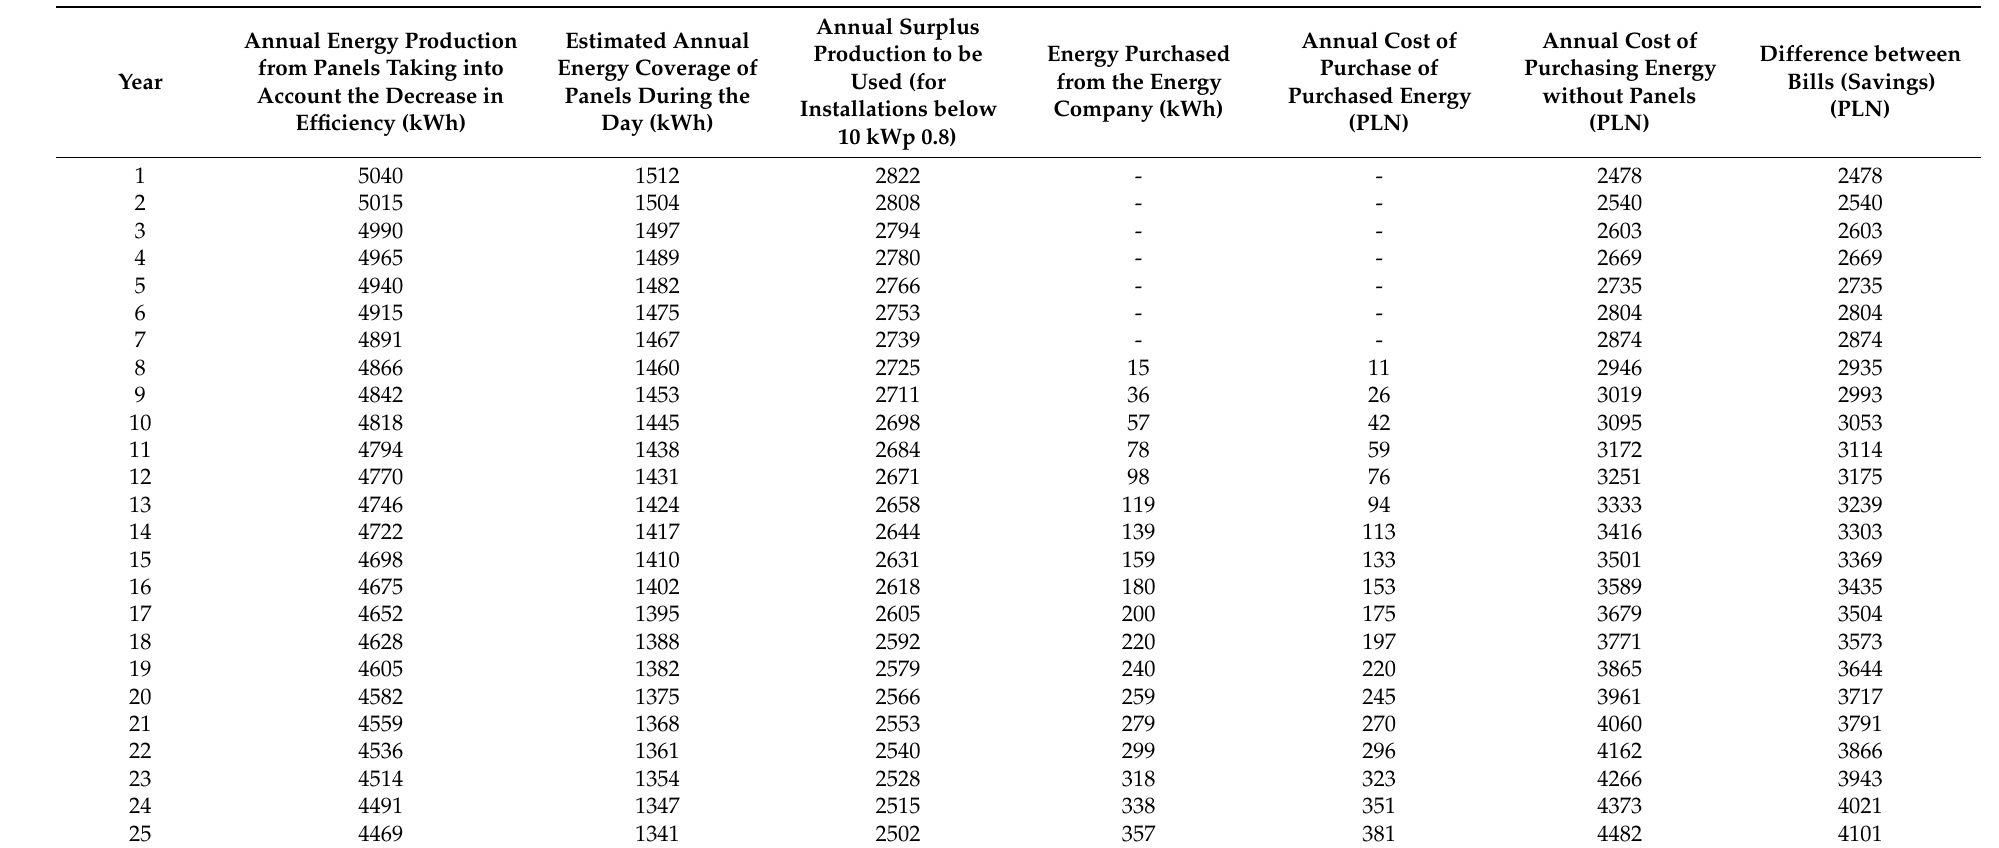
Table A1. The energy settlement with the net-metering